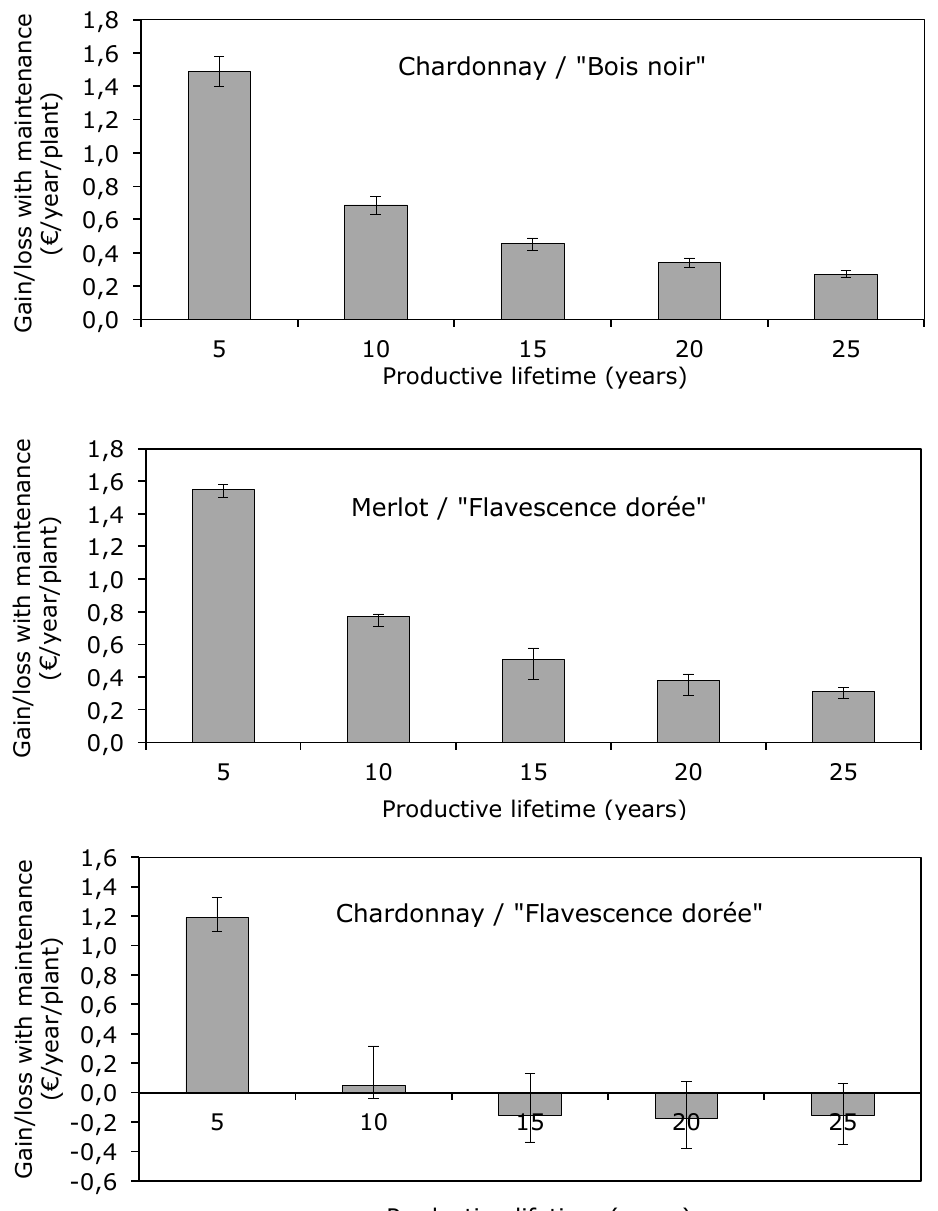
Figure 1. Average (max and min) gain or loss per year per plant for maintenance in comparison to replacement for the ten ‘Chardonnay’ vineyards affected by BN and for the four ‘Merlot’ and ‘Chardonnay’ vineyards affected by FD. Different productive lifetimes were